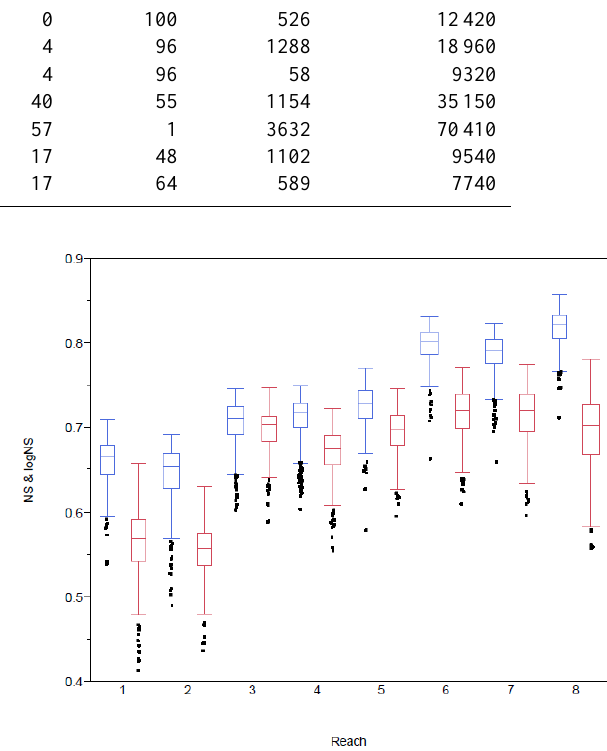
Fig. 5. Values for Nash–Sutcliffe (blue) and log Nash–Sutcliffe (red) goodness-of-fit statistics obtained for each reach from the en- semble of 500 credible model